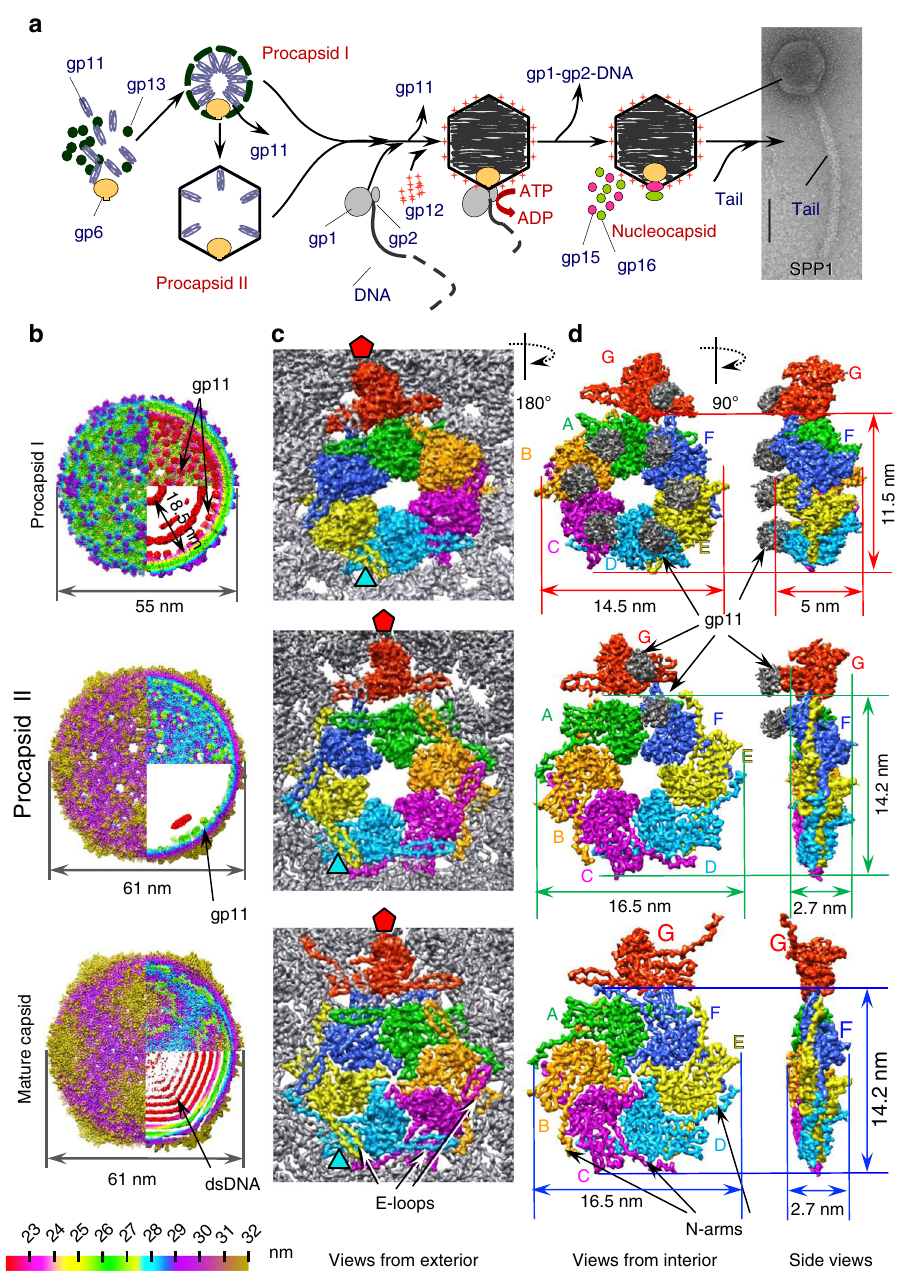
Fig. 1 3D structures of the SPP1 procapsids and mature capsid. a Schematic representation of bacteriophage SPP1 assembly pathway. b Structures of procapsid I, procapsid II, and mature virion capsid (MVC) (from the top to the bottom). The left part of the images shows the outer capsid surface, the top right quarter the inner side of the capsid shell; and the bottom quarter is a central slice of the structures. All structures are radially coloured from the origin to the outer surface. Procapsid I has three dense layers inside of the shell (shown in red) that were assigned to the gp11 SP. The outermost layer demonstrates well-de fi ned bulks of densities attached to the capsid shell. Procapsid II has such inner bulks of density only underneath pentons. The mature capsid has densely packed layers of dsDNA. c Asymmetric unit (ASU) of each structure is viewed from outside. d ASUs viewed from inside the (pro) capsids. The densities of the gp11 SP are in grey at a lower threshold. The right panels show the asymmetric units side view. Each subunit of the ASU is colour coded and labelled with letters according to the nomenclature used throughout the subunit goes underneath of the E-loop of the B subunit while the their central openings in the MVC (Fig. 1c, d, bottom panels). N-arm of the B subunit is located underneath the E-loop of the The P domain comprises a 50 Å long helix α 3 (the spine helix) C subunit and so on (Fig. 1c, d, bottom panel). The E-loop and three antiparallel β -strands with β 12 and β 13 connected by (Pro57-Gln84) extends by 42 Å on the other side of the P domain the P-loop. The N-arm (Ala2-Ala28) protrudes outwards from (Fig. 2a, Supplementary Figs. 2 and 3). The E-loop covers the the middle of spine helix α 3 by 70 Å, passing underneath the N-arm and P domain of the neighbour MCP on the right E-loop of a neighbouring subunit located on the left side side. Both N-arms and E-loops establish inter-capsomere (when observed from the capsid exterior). The N-arm of the A contacts (see below).